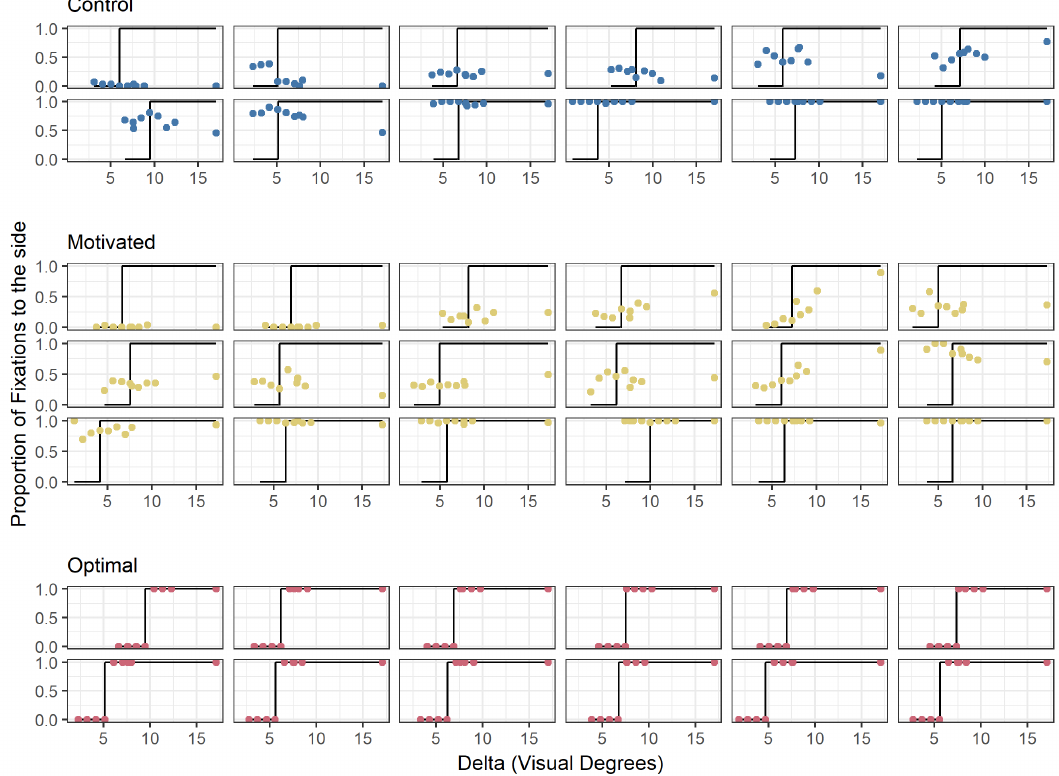
Figure 4. Plot of proportion of fixations to the side box ( y -axis) with increasing distance between the centre and side boxes (Delta, x -axis). Each separate plot shows the behaviour for an individual participant: bottom (in red) the behaviour of participants who were guided to employ an optimal fixation strategy; middle (in yellow) the Motivated group; and top (in blue) the Control group. The black line shows where participants would have fixated, had they made use of the optimal